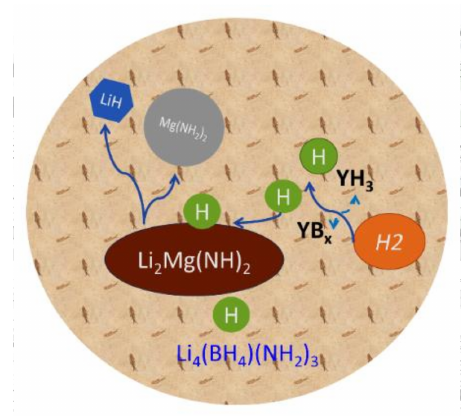
Figure 6. Scheme of the reaction mechanism proposed for the re-hydrogenation step in the co-additive 6Mg(NH 2 ) 2 + 9LiH + xLiBH 4 systems